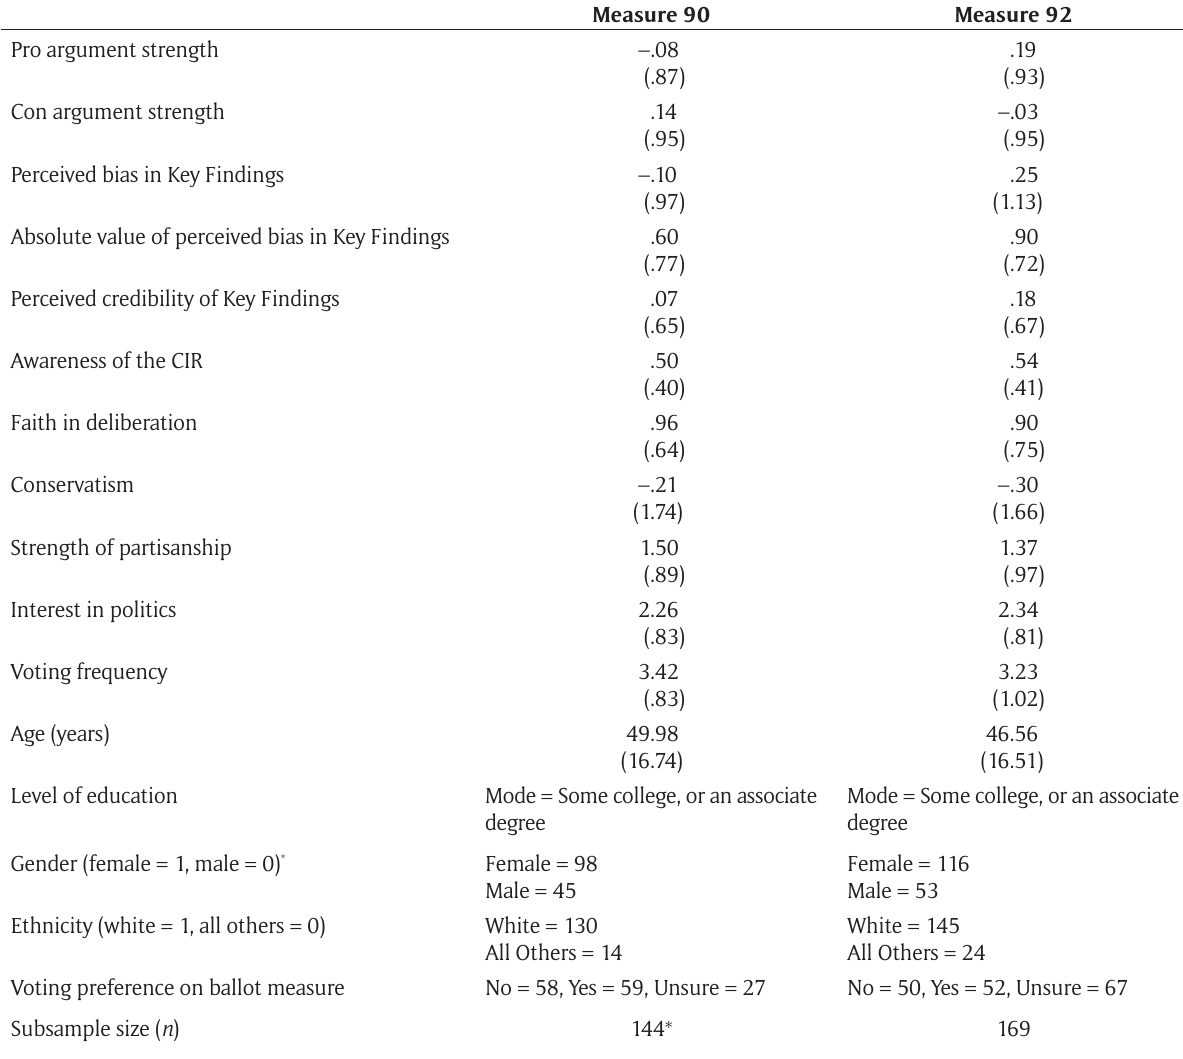
Table 2: Descriptive Statistics for Subsamples by Ballot Measure.